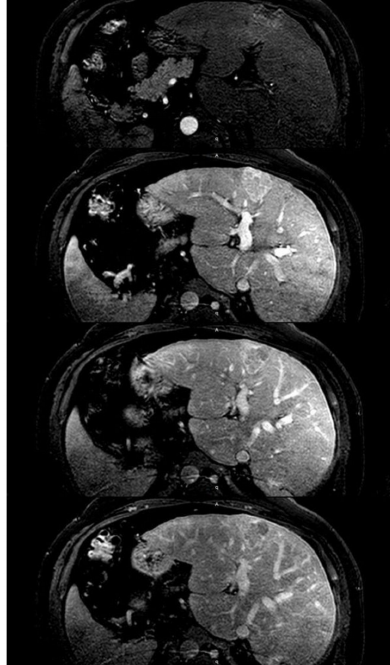
Figure 4. Idiopathic membranous inferior vena cava obstruction in a 44-year-old man. The image shows the dynamic phase of MRI. In addition to the significant hypertrophy of segment I, magnetic resonance imaging shows a mass (3.8 cm × 4.2 cm) that after administration of intravenous contrast presents a heterogeneous enhancement in the arterial phase with washout in the portal phase. Liver biopsy showed histological changes compatible with focal nodular